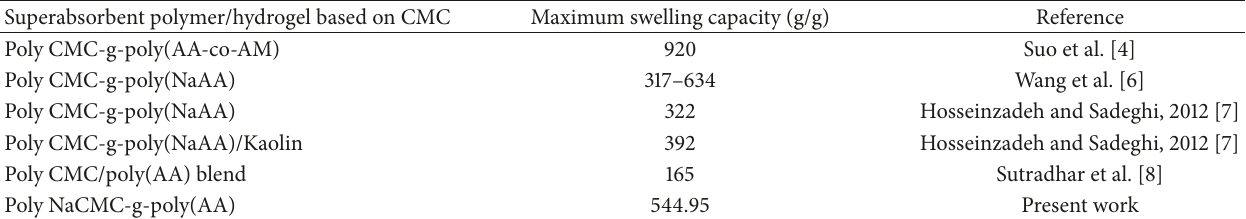
Table 1: The maximum swelling capacity in distilled water for some superabsorbent polymers/hydrogels based on CMC and free radical solution polymerization, with present results in the last row for